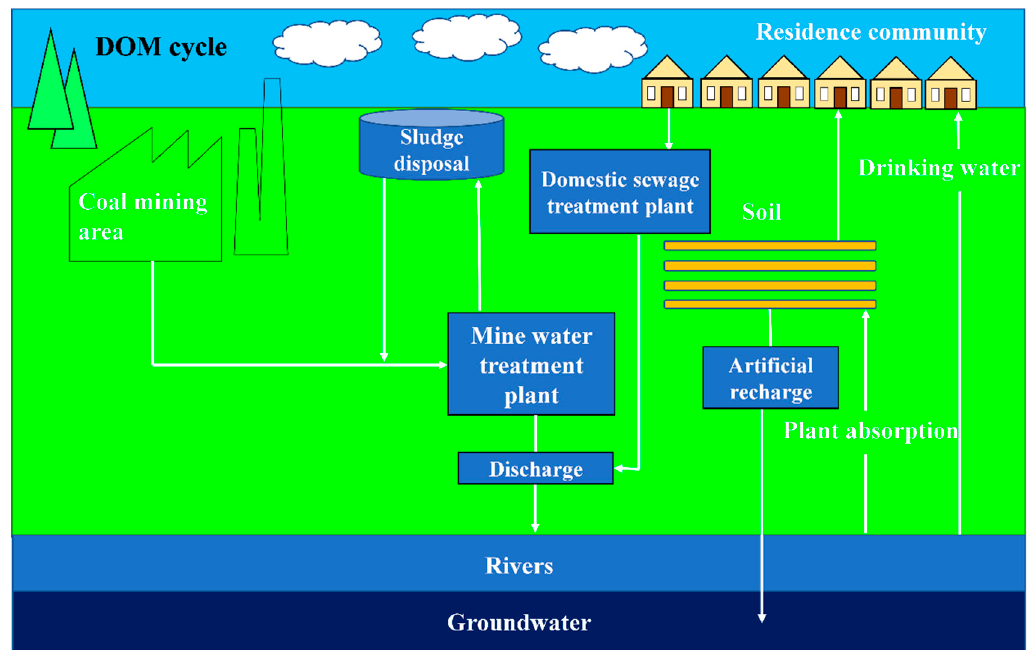
Figure 1. Schematic diagram of the DOM cycle in a coal mine area.